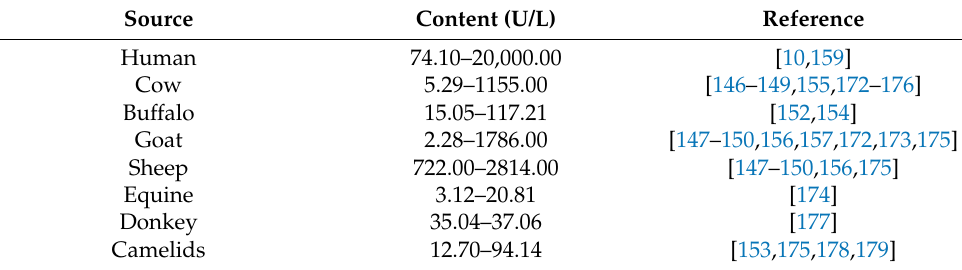
Table 2. Content of alkaline phosphatase in raw